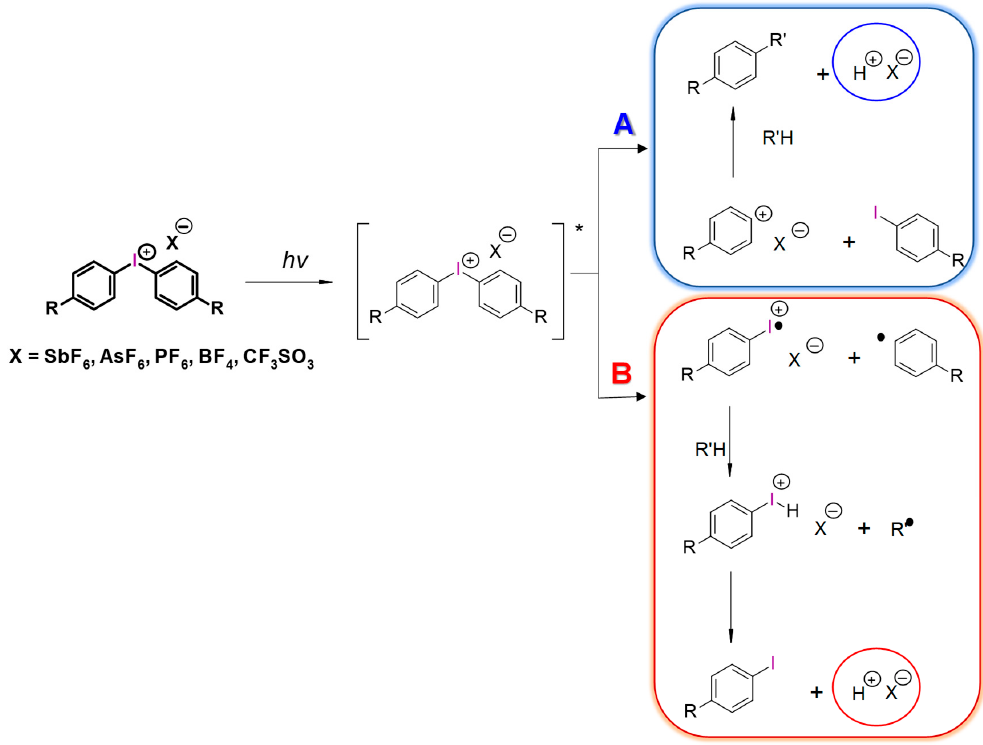
Figure 21. Photodissociation of iodonium salts by the mechanism: A—heterolytic and B—homolytic.